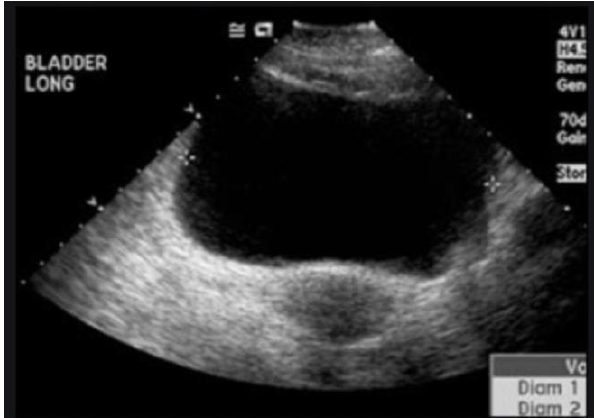
Figure 2 : Ultrasonographic image of a showing a distended bladder, which is common in Varicella Zoster Virus - induced urinary